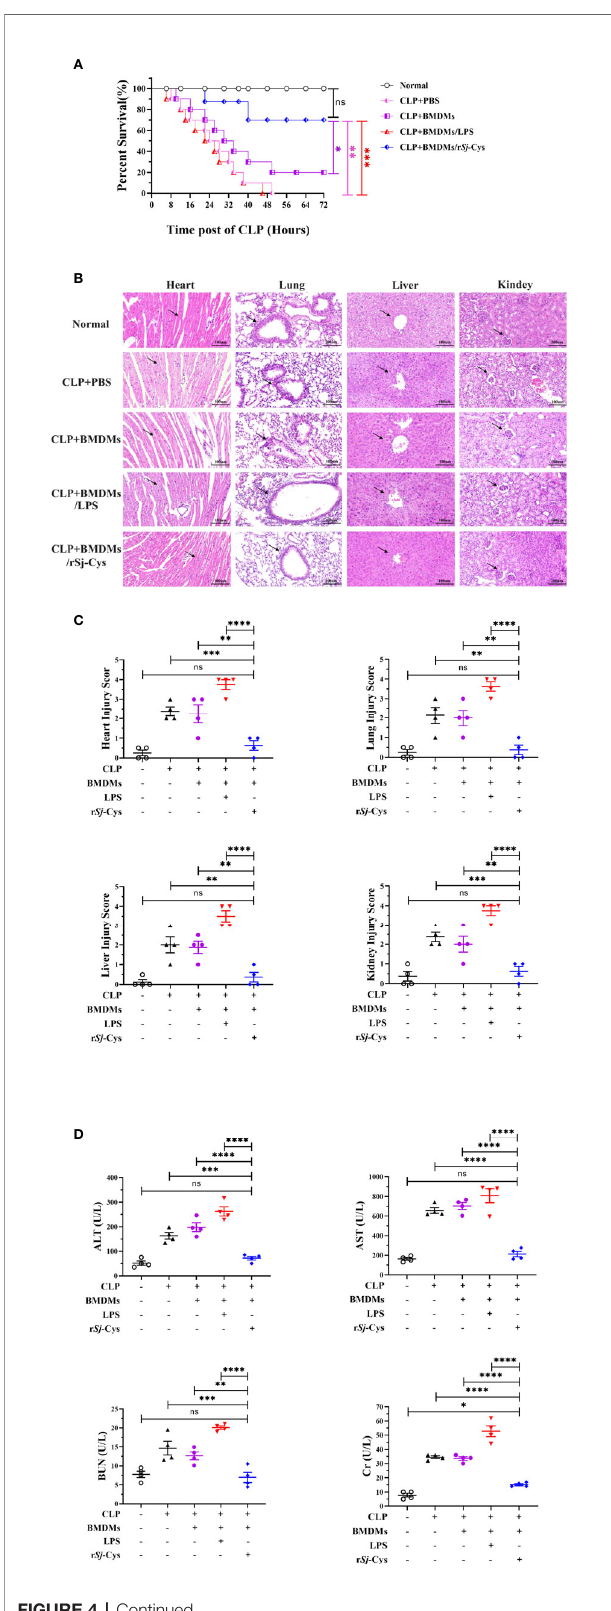
FIGURE 4 | Adoptive transfer of rSj-Cys treated-BMDMs mitigated pathology caused by CLP-induced sepsis. (A) Mice adoptively transferred with r Sj -Cys-treated BMDMs signi fi cantly increased their survival rate up to 72 h (80%) compared to mice receiving PBS (0%), LPS-treated BMDMs (0%), or untreated BMDMs (20%) during the same observation period (n = 10). (B, C) The results of histopathology of heart, lung, liver and kidney stained with H&E staining from mice 12 h after CLP and transferred with BMDMs treated with r Sj -Cys, LPS or untreated BMDMs (n = 4). The pathological score comparison was shown on the right. The magni fi cation ×400, scale bar = 100 µm. (D) The levels of ALT, AST, BUN, and Cr were measured in the sera from mice 12 h after receiving CLP and differently treated BMDMs (n = 4). The results are presented as mean ± SEM. ns,